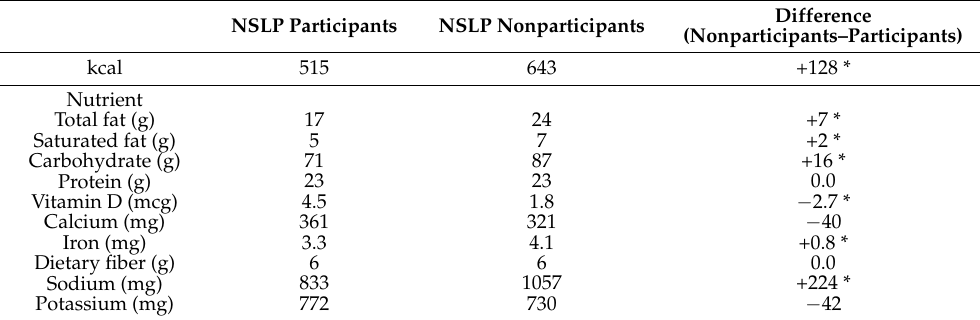
Table 1. Lunchtime dietary intake, comparing National School Lunch Program participants and matched nonparticipants on a typical school day.